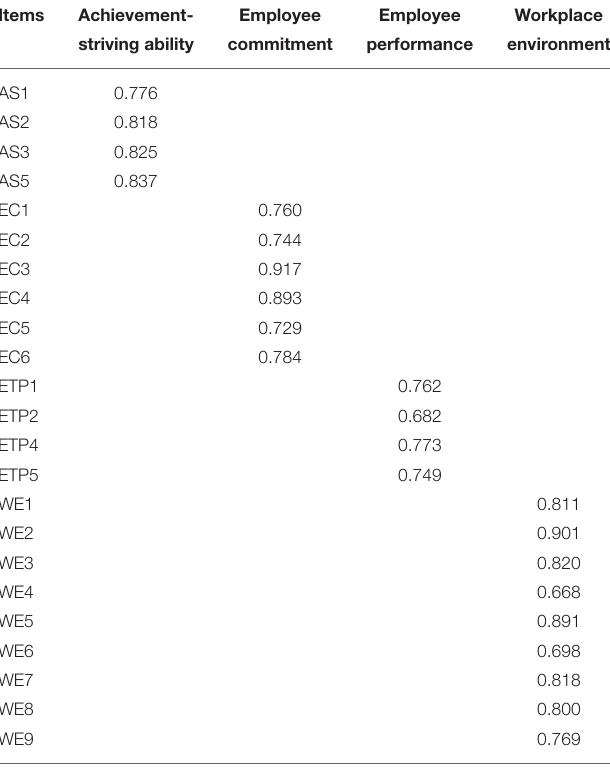
TABLE 2 | Outer loadings (convergent validity).